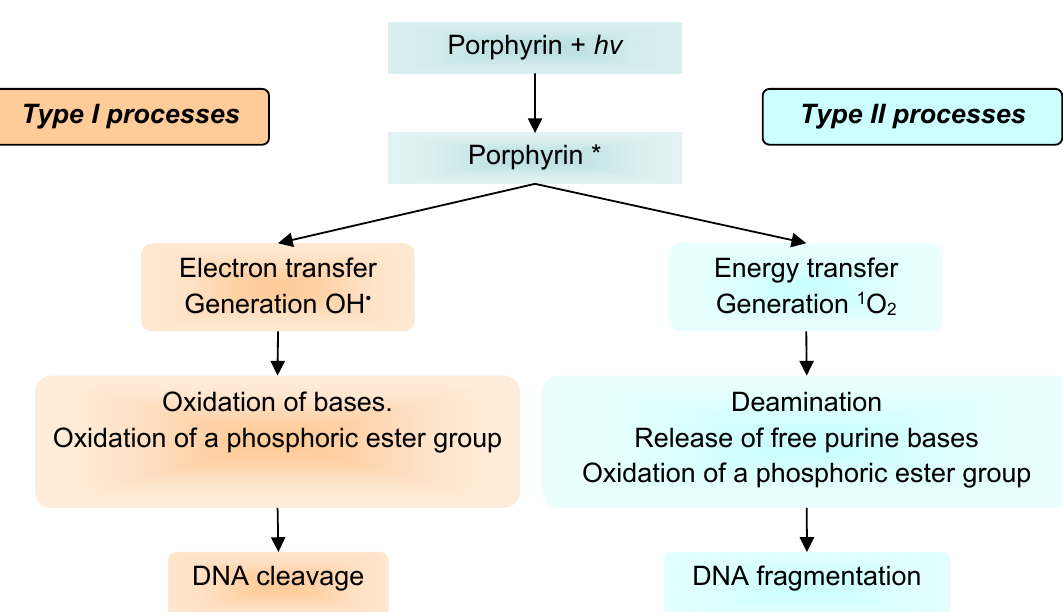
Figure 11. Scheme of DNA photoreactions of type I and type II. * excided triplet state.